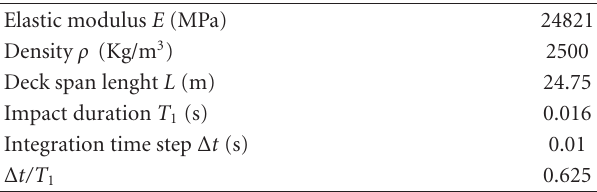
Figure 12: Displacement time histories for stations 1 to 8: (a) highly correlated time-histories (set 1/5 v s /α = 1200 m/s. Table 2: Integration time step adopted Δ t